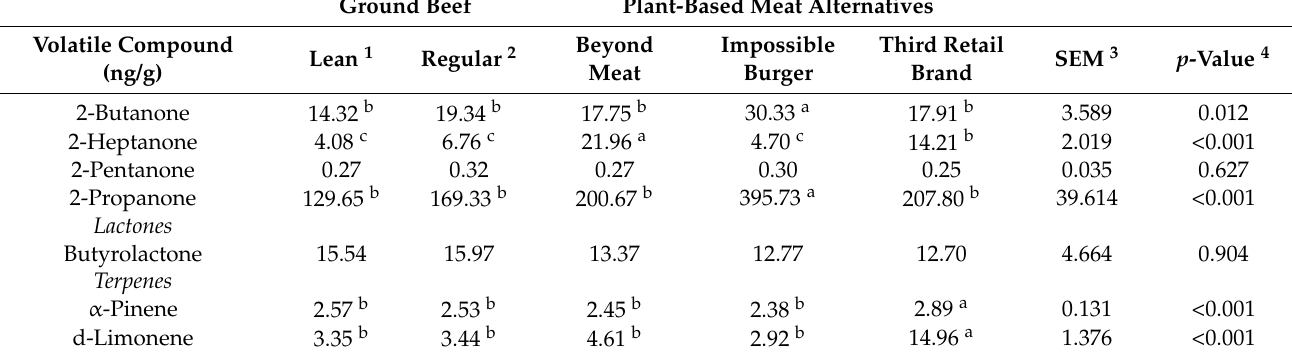
Table 4. Cont. Ground Beef Plant-Based Meat